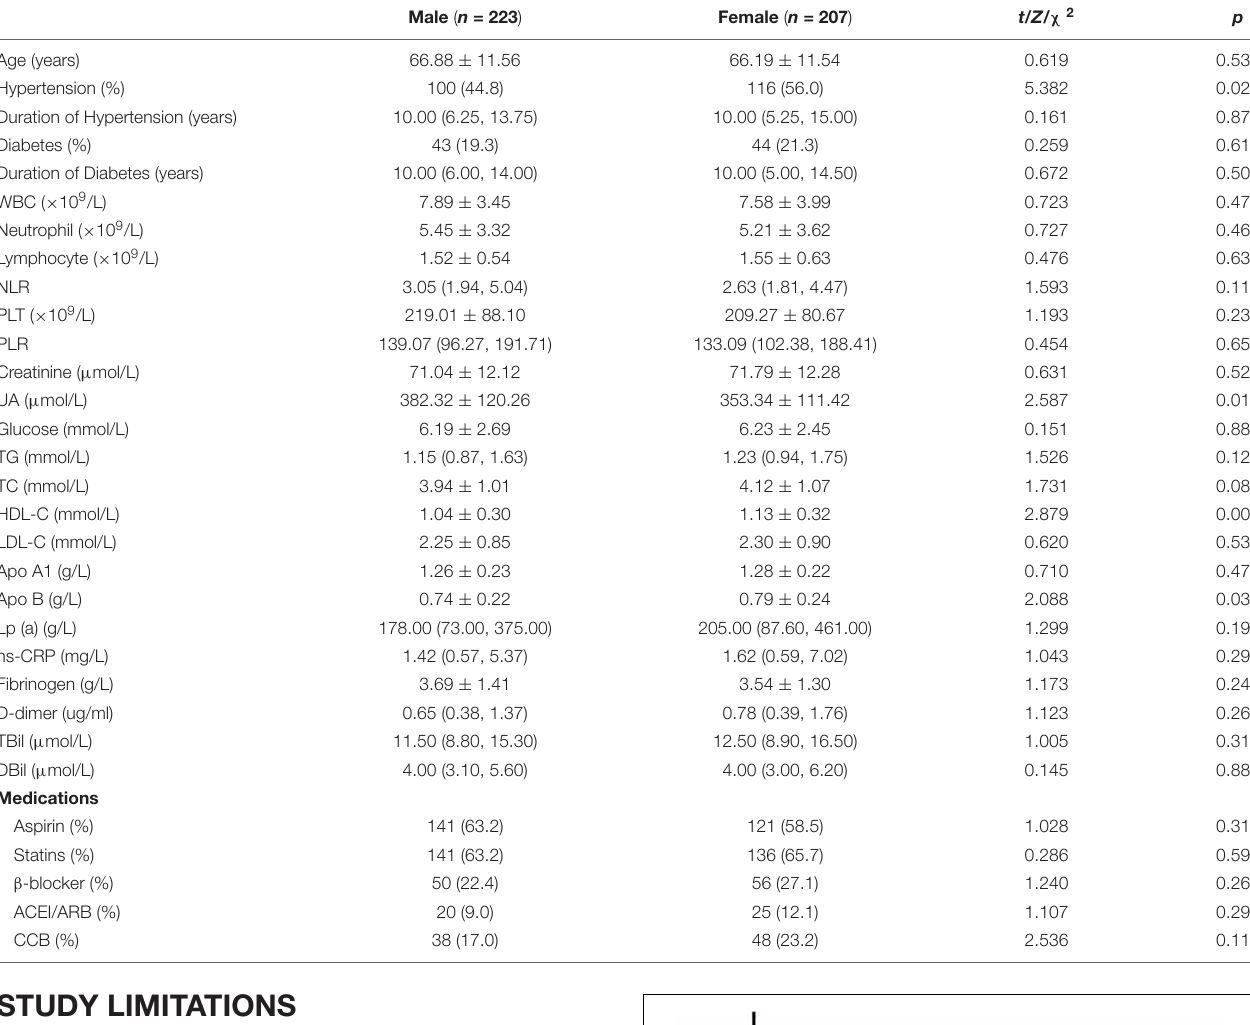
TABLE 6 | Characteristics of male and female patients with LEASO.